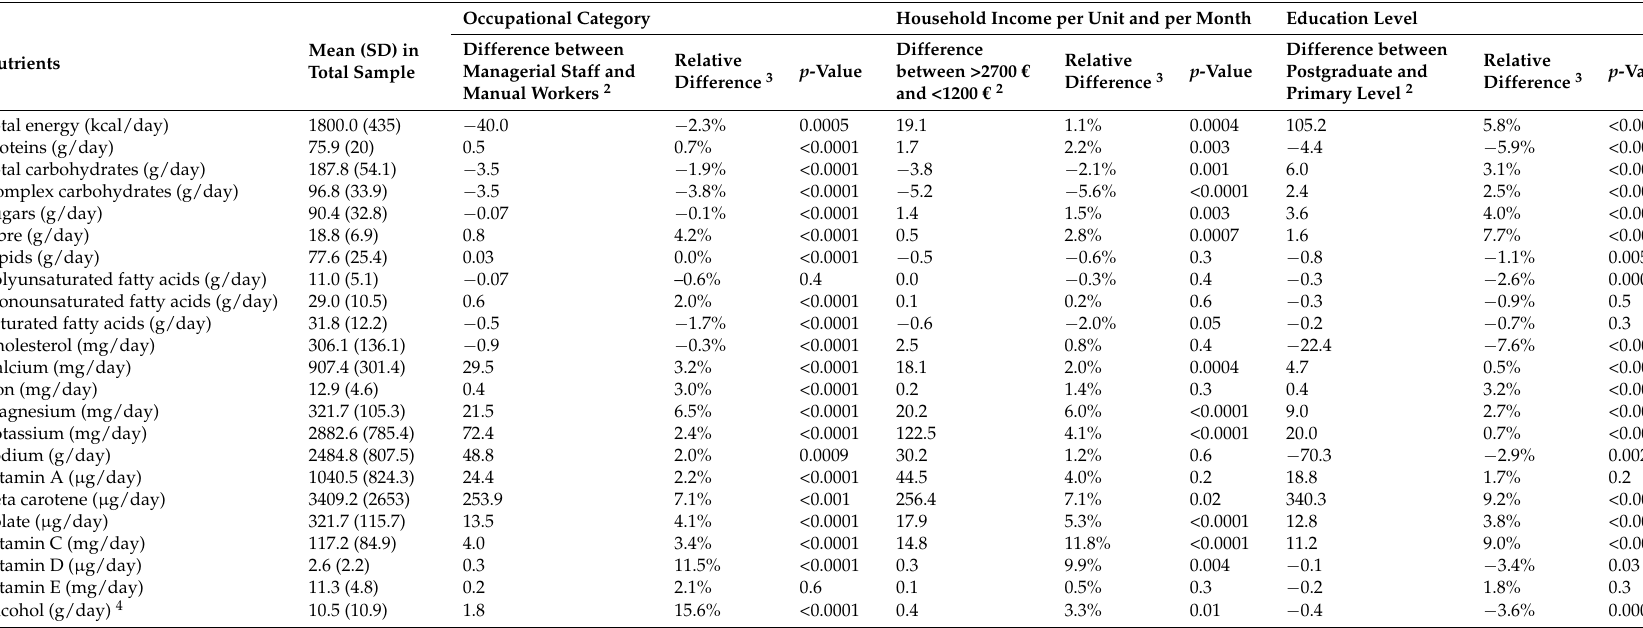
Table 2. Differences in nutrient intake between the highest and the lowest socioeconomic position (SEP) categories of occupation, household income and education in women ( N = 72,154) 1